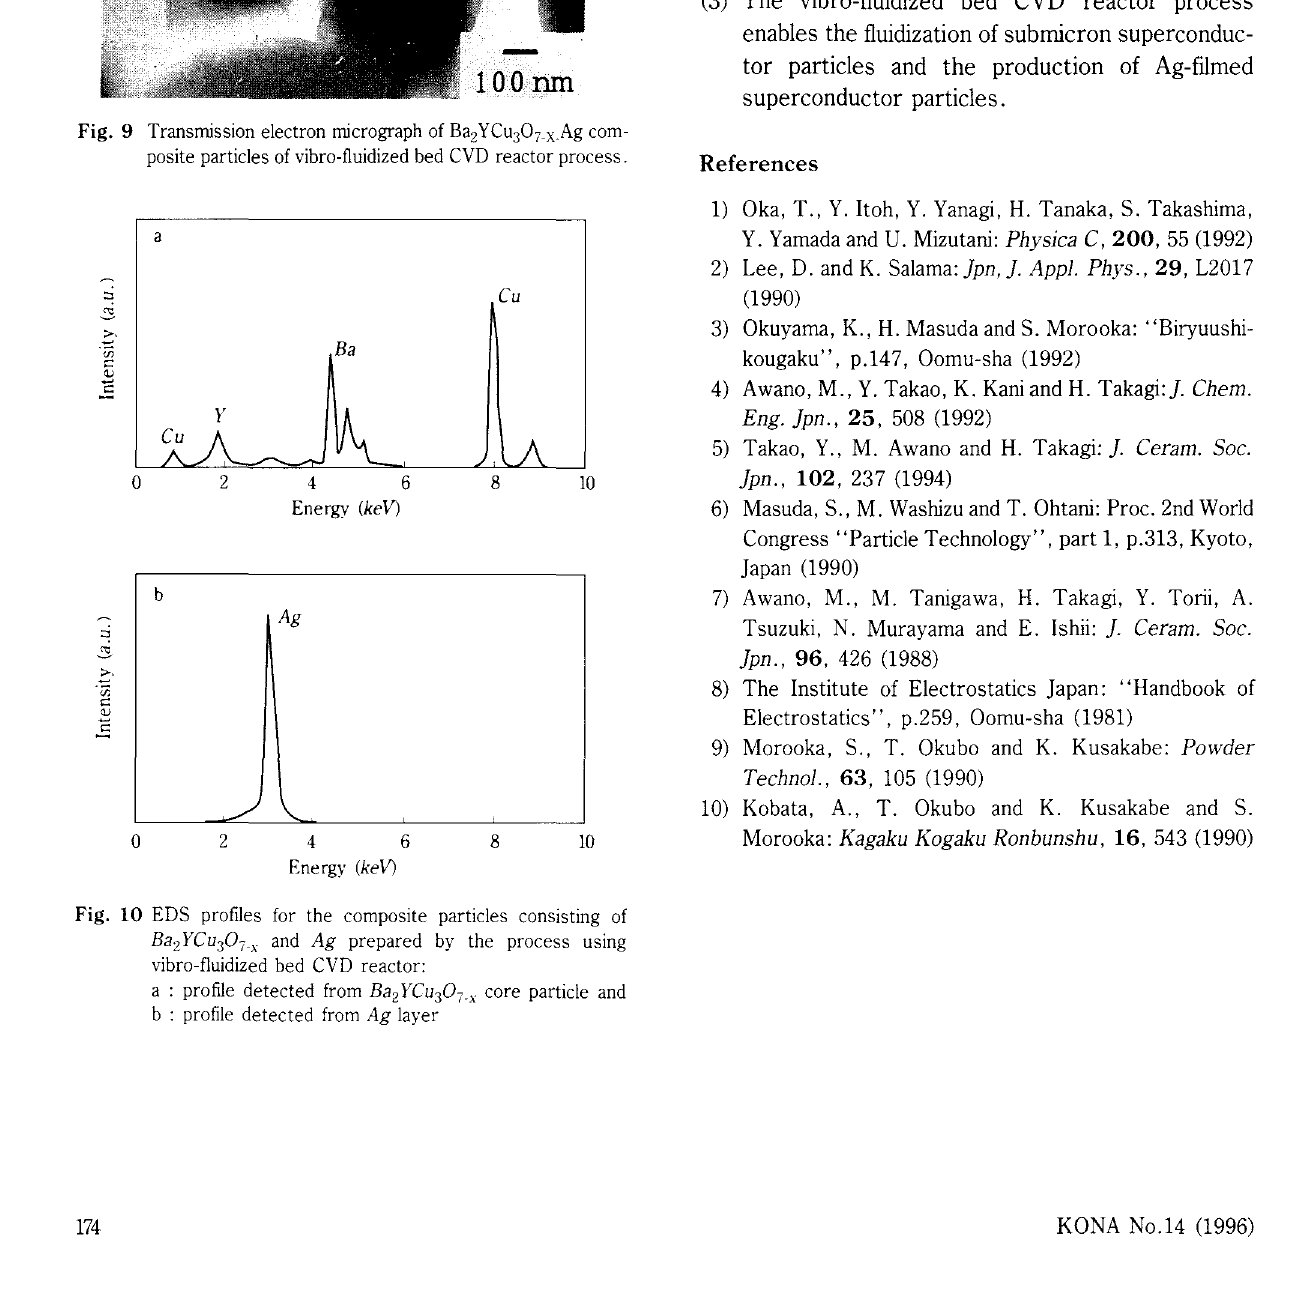
Fig. 9 Transmission electron micrograph of Ba 2 YCu 3 0 7 _xAg com posite particles of vibro-fluidized bed CVD reactor process.